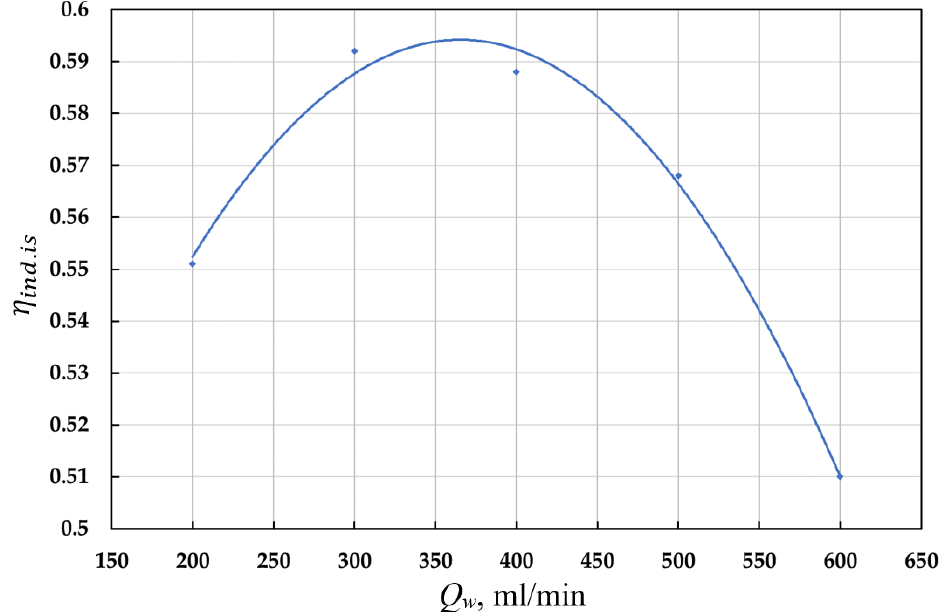
Figure 8. Dependence of the indicator isothermal efficiency of the compressor on the coolant flow rate.